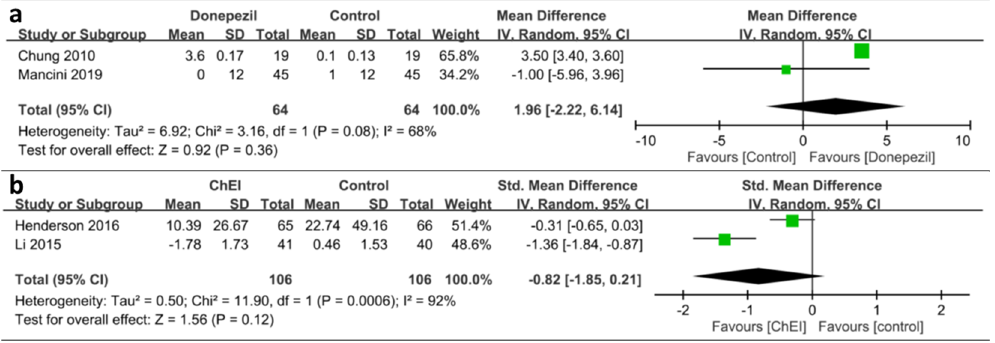
Fig. 3 Effect of cholinesterase inhibitors (ChEIs) on the balance and fall frequency of patients with Parkinson disease (PD). a Trending but nonsigni fi cant bene fi cial effects were conferred for balance improvement (Standardized Mean Difference [SMD]: 1.96, 95% Con fi dence Interval [CI]: − 2.22 to 6.14, p = 0.36). b The effect of ChEIs on fall reduction was not signi fi cant (SMD: − 0.82, 95% CI: − 1.85 to 0.21, p =